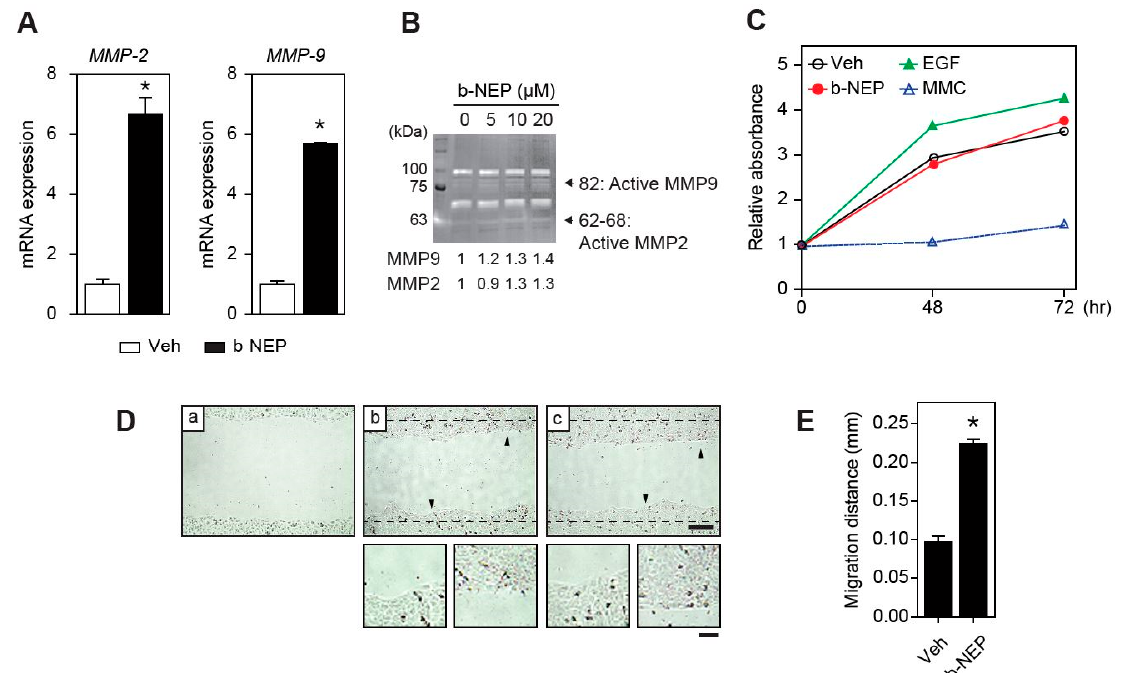
Figure 3. β -NEP stimulates keratinocyte migration through activation of metalloproteinase (MMP)-2 and -9. ( A ) Expression of MMP-2 and -9 after β -NEP treatment for 24 h. ( B ) Gelatin zymography assay to measure MMP-2 and -9 activities after β -NEP treatment for 12 h. Relative intensity listed below was calculated using ImageJ software. ( C ) Cell growth analysis after β -NEP and EGF treatments for indicated time periods. Mitomycin C (MMC, 2.5 μ g/mL) was used to inhibit cell proliferation. ( D ) HaCaT cells were scratched (a, T0) and treated with vehicle (b) or β -NEP (c) for 30 h in the presence of MMC. Scale bar = 200 μ m. The arrowhead indicates that the region of magnification and magnified cell image are located at the bottom (scale bar = 20 μ m). ( E ) Migration distance was measured from ( D ). Results represent the mean of three independent experiments. Data represent mean value ± SEM (* p < 0.05, Student’s t -test).